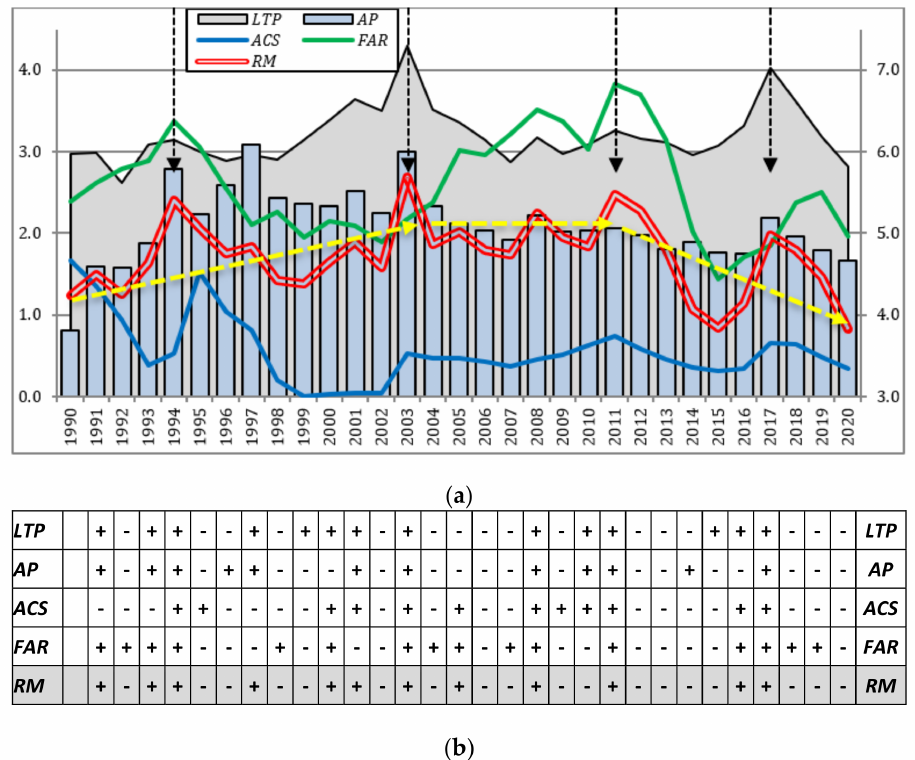
Figure 4. Restructuring evaluation results: ( a ) restructuring measure ( RM ) and its components for coal mining companies in 1990–2020; ( b ) direction of change in RM and its components for coal mining companies in 1990–2020. Note: standardised values, stimulants. RM —right axis. Direction of change: (+) increase; ( − ) decrease. Source: as in Figure